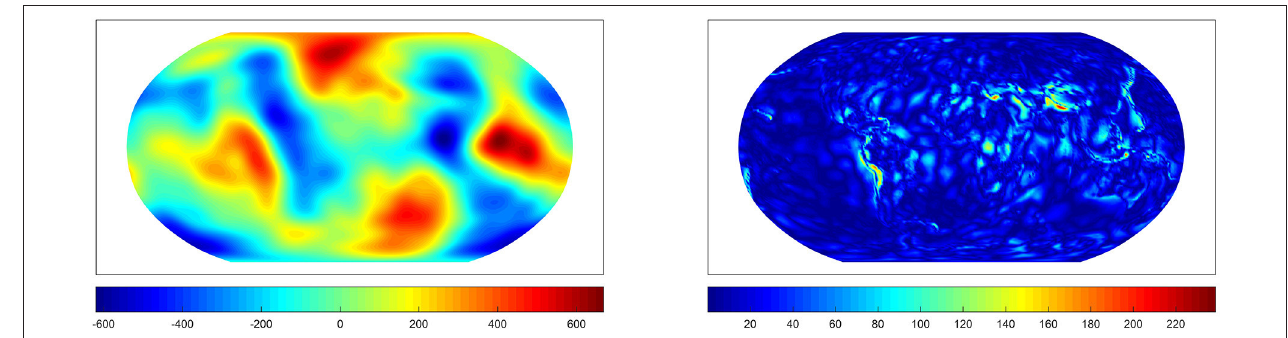
FIGURE 13 | The approximation from the ROFMP for the best parameter (Left) and the difference to the EGM2008 up to degree 100 (Right) . Values in m 2 / s 2 .